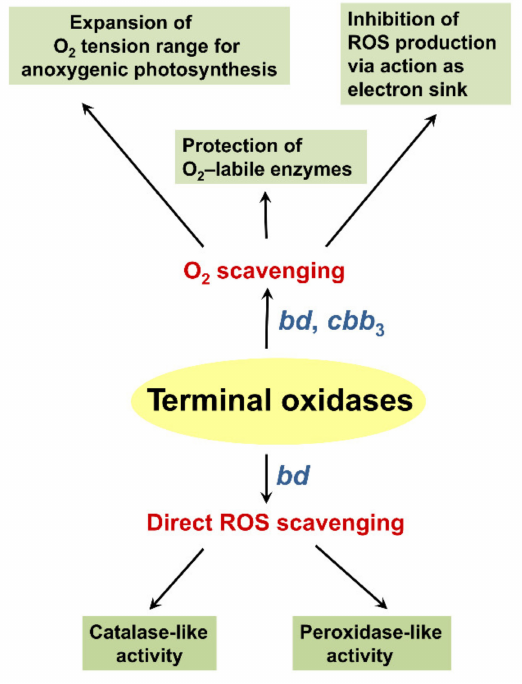
Figure 8. Overview of the proposed contribution of terminal oxidases to ROS defense mechanisms in